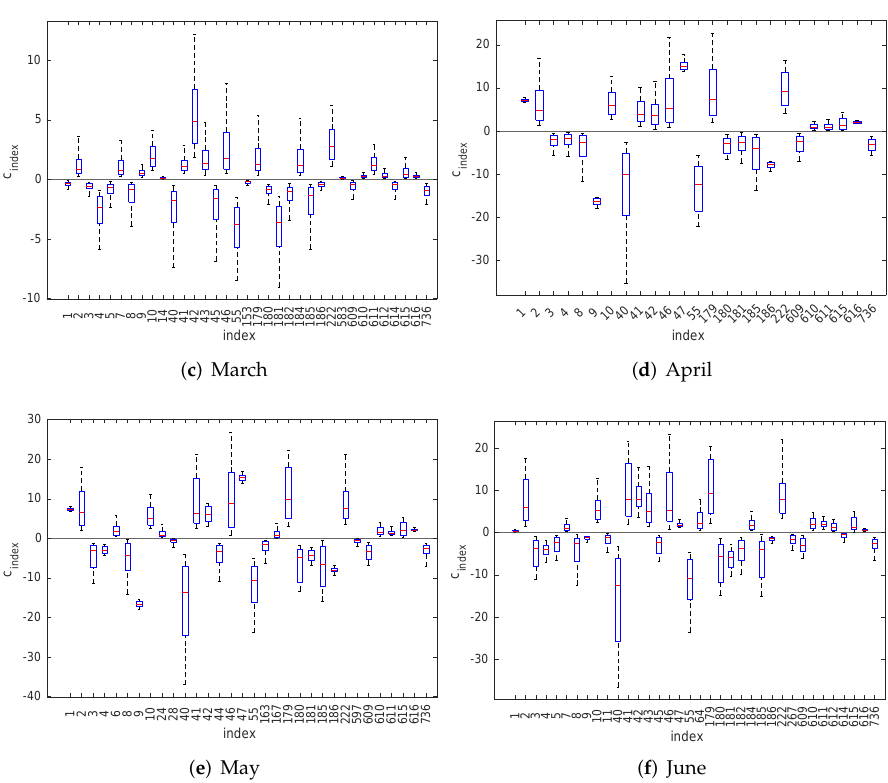
Figure 3. Box-plots of the posterior PC coefficients: